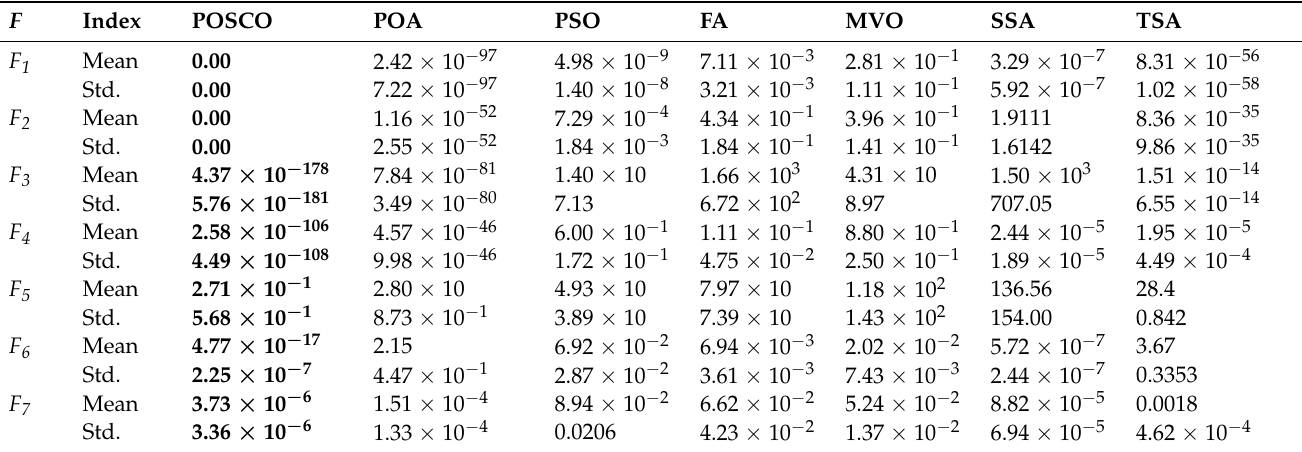
Table 5. Results of unimodal test functions comparison.